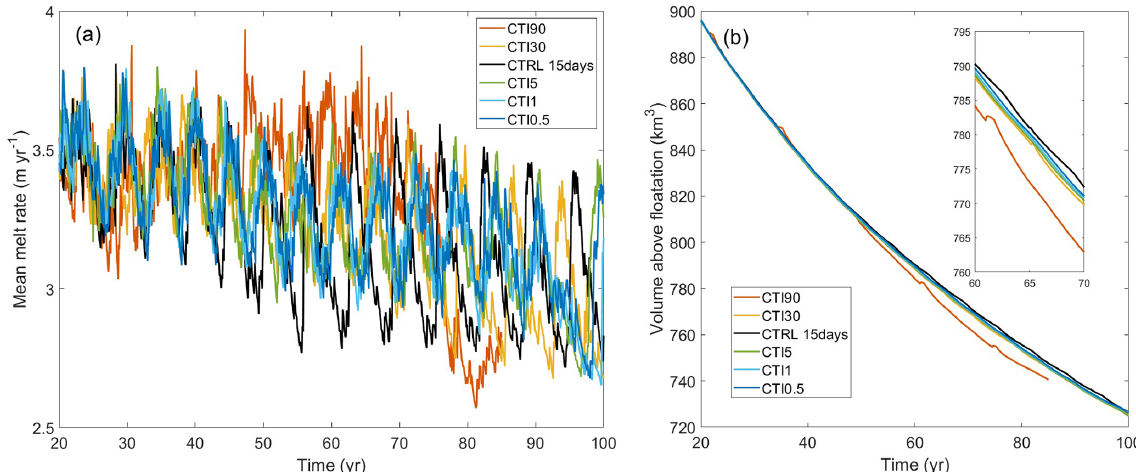
Figure 6. (a) Simulated mean melt rates and (b) ice volume above floatation with different coupling intervals. The inset box in (b) is the zoomed-in period between year 60 to year